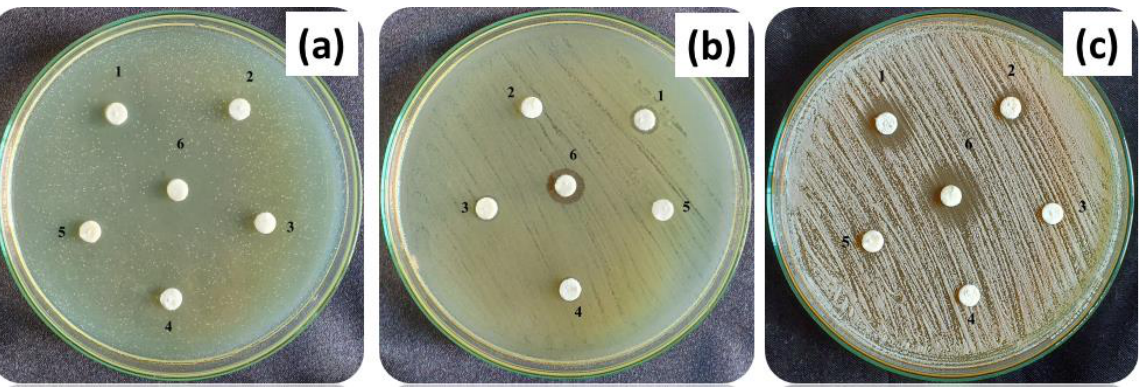
Figure 12. Comparison of CIP release behavior of BCP and Ag-BCP.